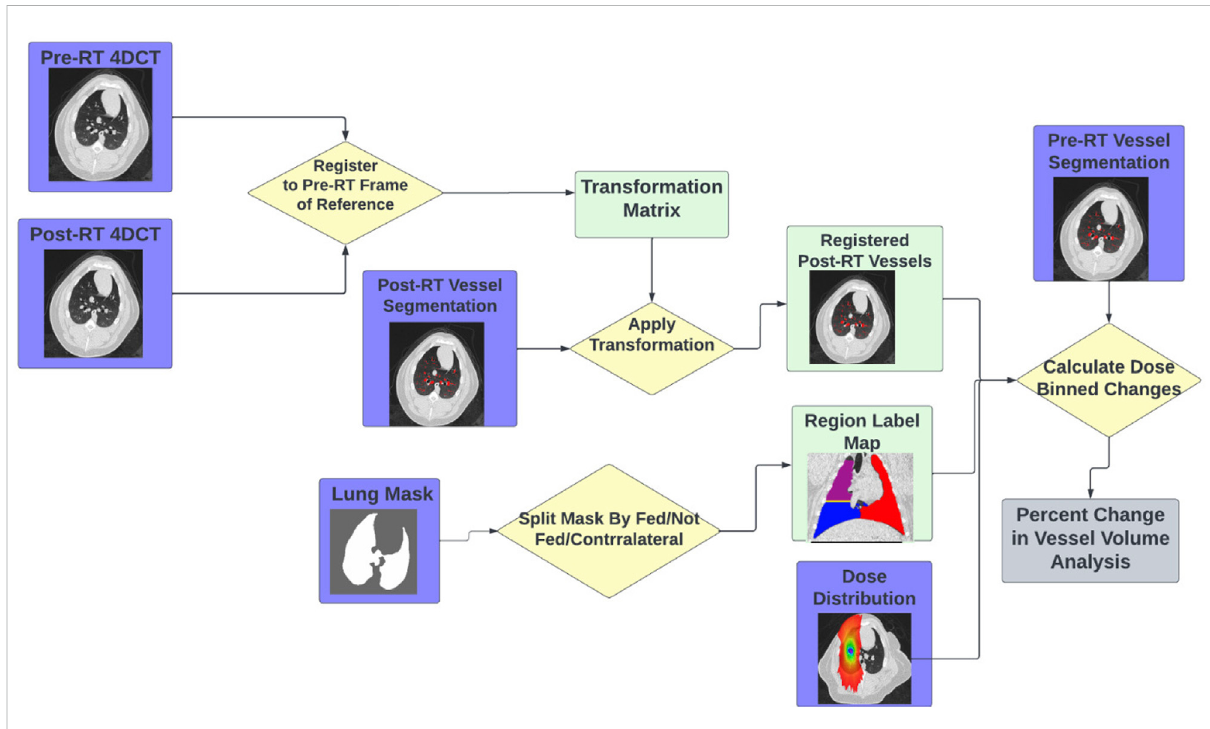
FIGURE 4 Flowchart showing the work fl ow to perform the indirect vascular change analysis using the tools